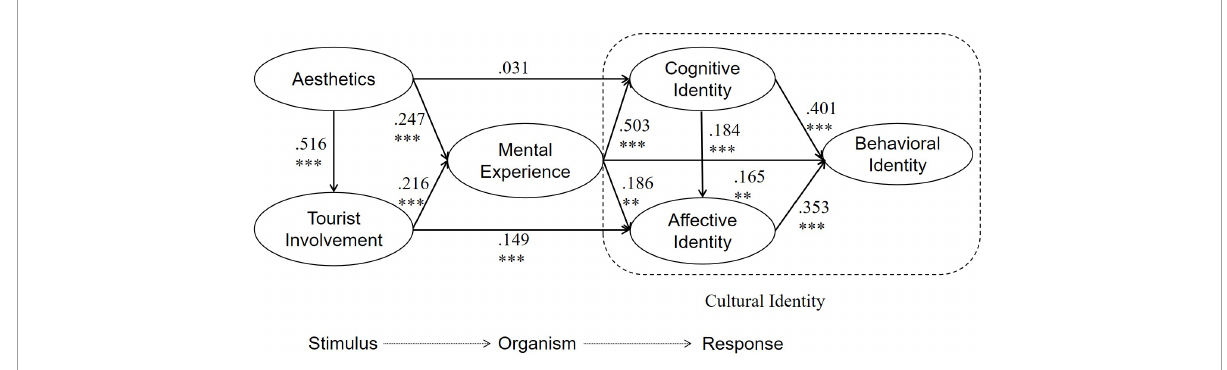
FIGURE4 Result of the SEM. The symbol ** is significant at the 0.01 level and the symbol *** is significant at the 0.001 level.